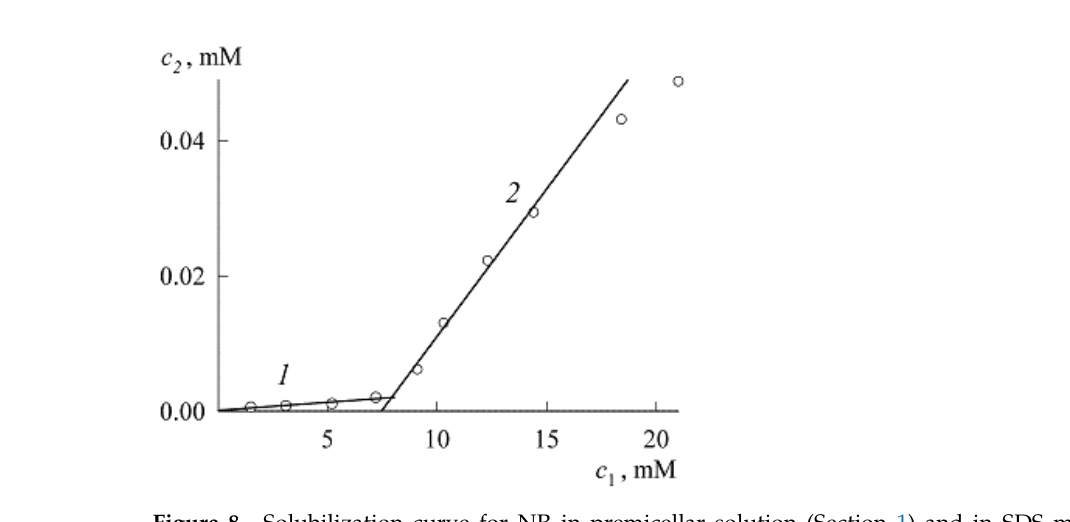
Figure 7. Absorption spectrum of NR in a weak solution of SDS at concentrations c 1 = 1.5 mM and c 2 = 1.4  M.